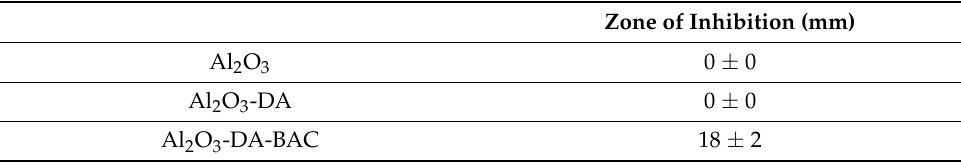
Table 2. Zone of inhibition diameter obtained for the tested particles against Escherichia